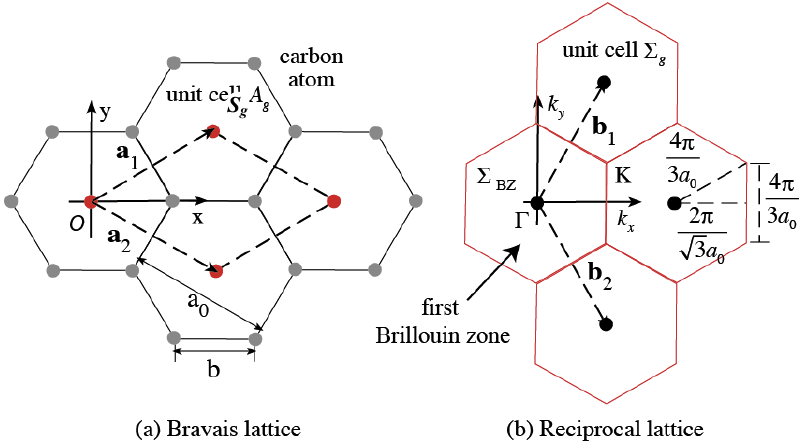
Figure 1. The structure of graphene. ( a ) Bravais lattice; ( b ) reciprocal